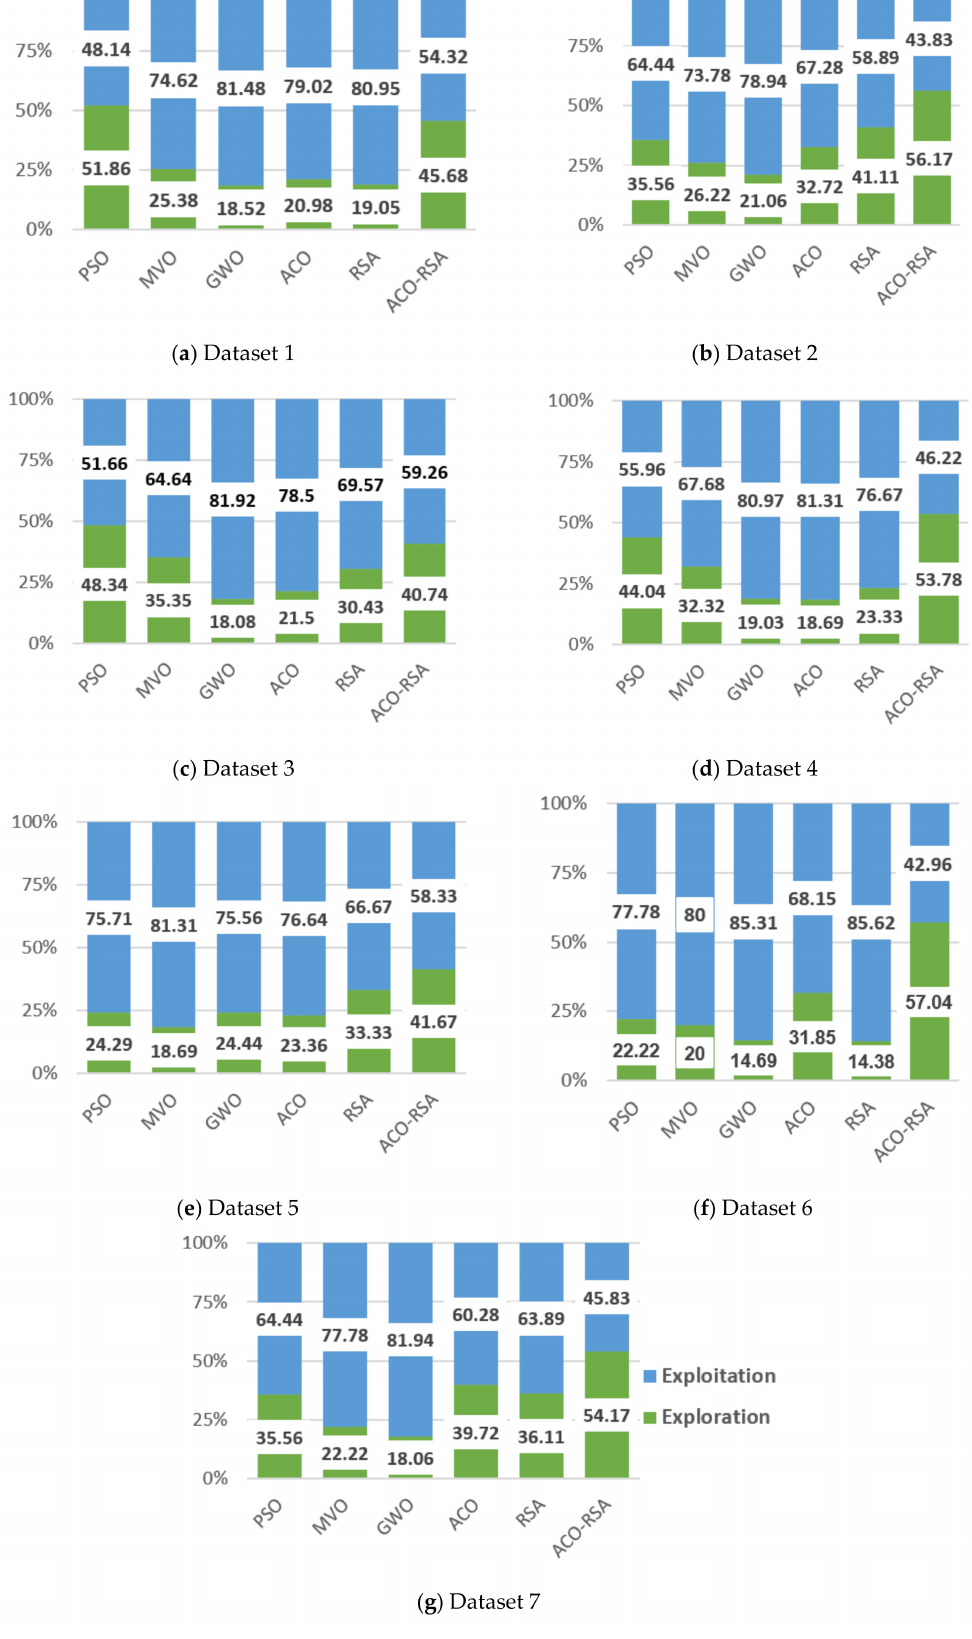
Figure 7. Exploration and exploitation ratio maintained by MAs on each